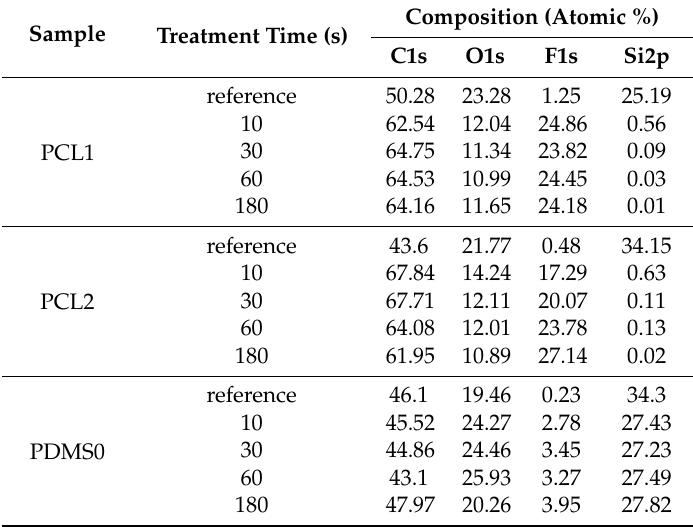
Table 3. Elemental composition after SF 6 treatment (30 W) on PCL and PDMS surfaces. In treatment time column, the “reference” represents 0 s or untreated